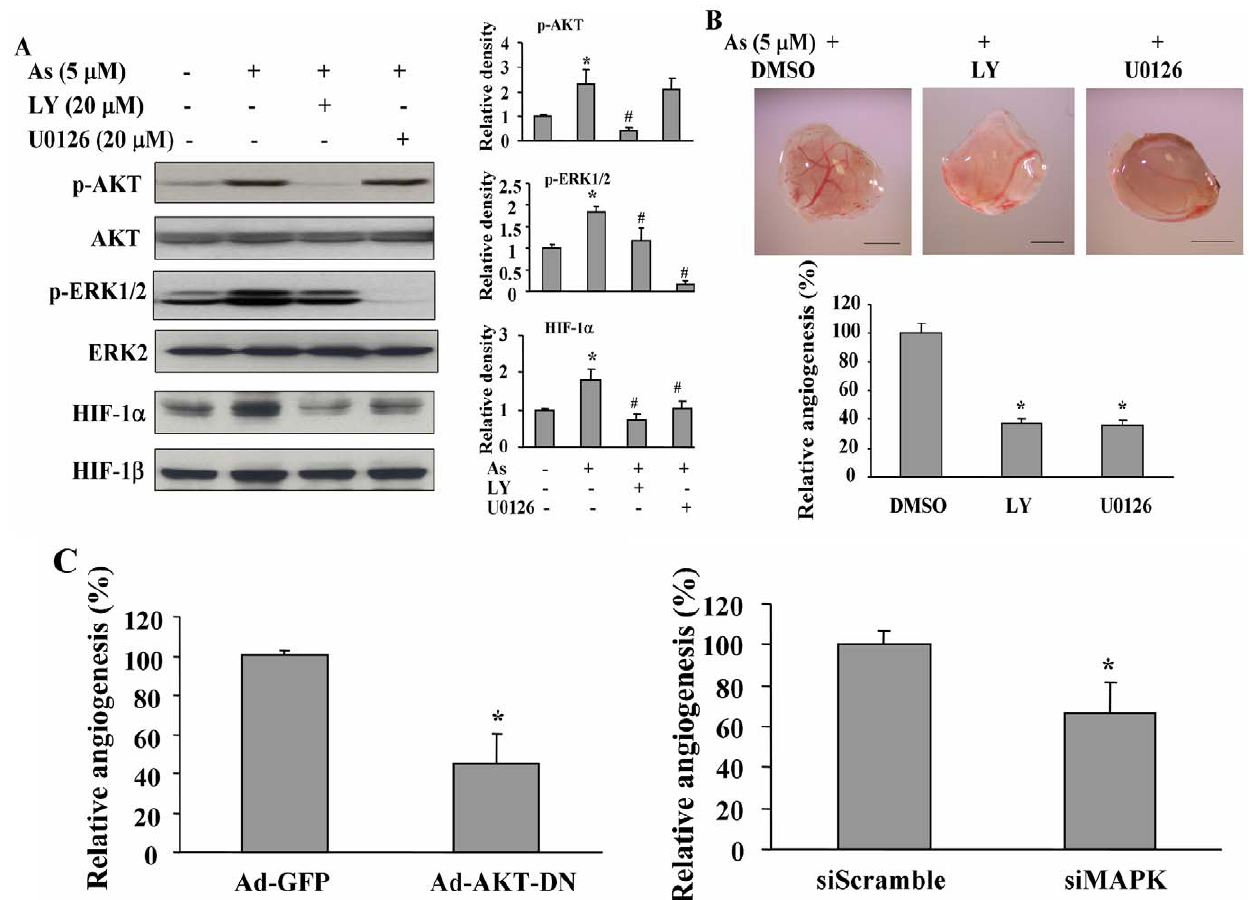
Figure 3. AKT and ERK1/2 pathways are required for arsenic-inducing HIF-1 a expression and angiogenesis. (A) BEAS-2B cells were cultured in serum-free medium for 24 h, then cells were pre-treated with LY294002 or U0126 at 20 m M for 30 min. Arsenic at 5 m M was added to the cells for 2 h (for p-AKT, AKT, p-ERK1/2, and ERK2 expression) and 6 h (for HIF-1 a and HIF-1 b expression), respectively. Total proteins were analyzed by Western blotting to detect the expression of proteins as indicated (left panel). Relative densities of p-AKT, p-ERK1/2 and HIF-1 a were analyzed as Fig. 2A (right panel). *, indicates significant increase when compared with the control cells, P , 0.05. . # , indicates significant decrease when compared with the sodium arsenite treatment, P , 0.05. (B) BEAS-2B cells were treated with 5 m M of arsenic. Cells were trypsinized, mixed with equal volume of Matrigel with or without 15 m M of LY294002 or U0126. Equal volume of DMSO was added as a negative control. Angiogenesis assay was performed as described in Fig. 1. *, indicates that the relative angiogenesis index was significantly decreased when compared with DMSO control group, P , 0.05. (C) BEAS-2B cells were infected with adenovirus carrying GFP (Ad-GFP) or AKT dominant negative (Ad-AKT-DN) at 20 MOI (upper panel), or transfected with scrambled control of siRNA (siScramble) or siMAPK at 50 nM (bottom panel). After 24 h, cells were treated with arsenic and angiogenesis assay was performed as above. *, indicates that the relative angiogenesis index was significantly decreased when compared with Ad- GFP or siScramble control group, P ,